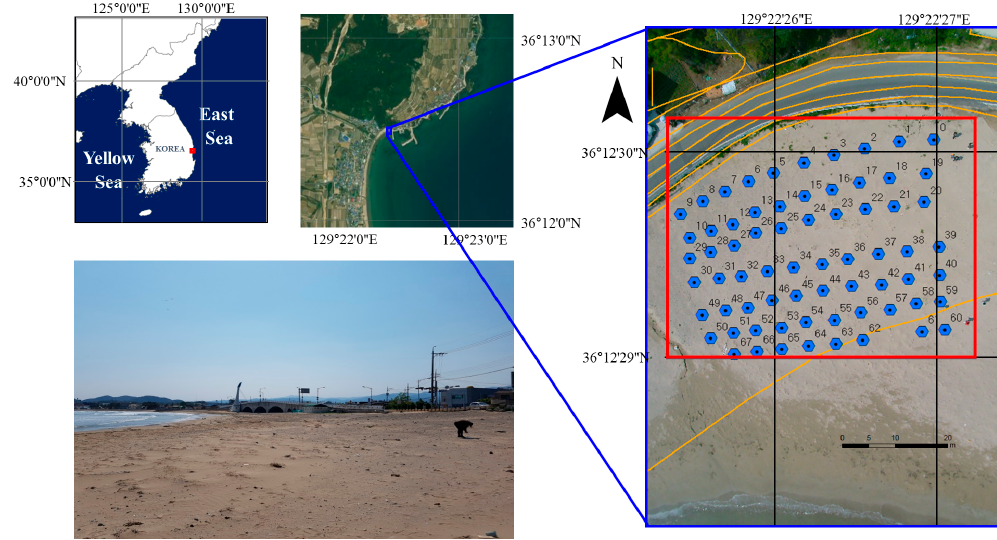
Figure 1. Sampling points in the target area of the eastern coast.